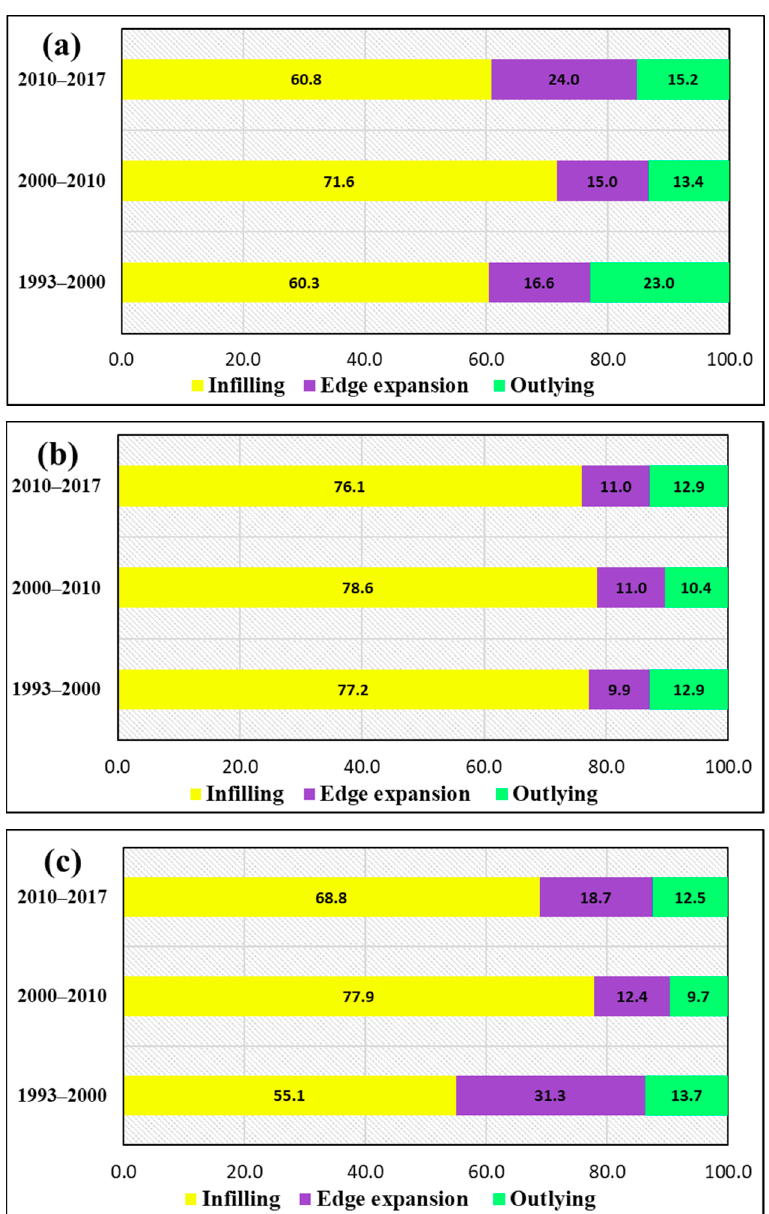
Figure 9. Percentages of area for the urban growth types in the three cities: ( a ) Bishkek, ( b ) Osh and ( c ) Jalal-Abad.